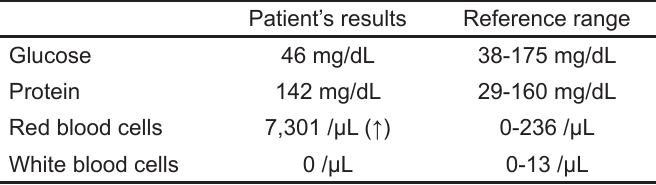
Table 2. Results of cerebrospinal fluid analysis shows traumatic lumbar